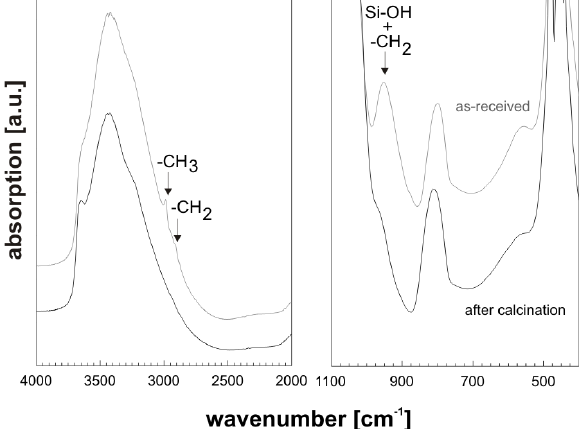
Figure A1. FTIR spectra of the silica particles before and after coating with molybdenum oxide by combined CVS/CVD. The additional peaks in the coated sample at 955, 914 and 563 cm −1 can be assigned to terminal double-bond Mo=O vibrations in surface molybdates [32], Mo–O–Si linkage vibrations [33] and single bond Mo–O vibration in octahedral MoO 6 units [34], respectively. The broad band in the range of 600–900 cm −1 is due to overlapping Mo–O single bond and Mo–O–Mo vibrations of Mo–Ions in tetrahedral and octahedral coordination and typically observed in nonstoichiometric molybdenum oxides [35].